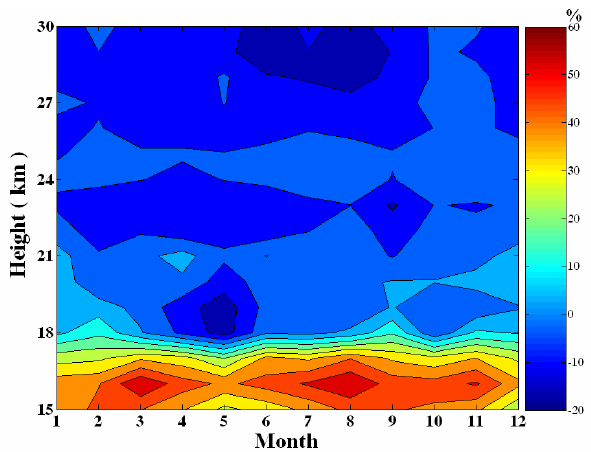
Fig. 6. The monthly mean percentage of differences in between The monthly mean percentage of differences in between HALOE and ozonesonde with respect HALOE and ozonesonde with respect to the ozonesonde value. to the ozonesonde value.